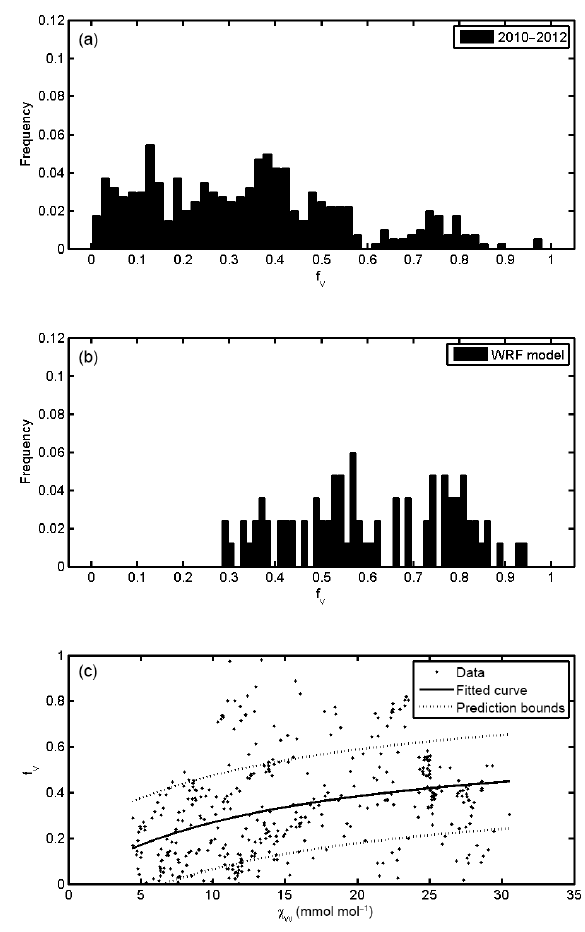
Figure 9. Normalized frequency distributions of PBL water vapor partitioning ( f v ) for June to August 2010–2012 (a) and normal- ized frequency distribution for estimates derived from the Weather Research and Forecasting (WRF3.5) model simulations for June– August 2010 (b) . Here, the average daytime values represent the fraction of water vapor in the PBL derived from local evapora- tion evaluated under the following conditions, evaporation>0, and − u d X/ d x >0 and − v d X/ d y >0. Panel (c) shows the fraction of evaporated vapor contained in the planetary boundary layer as a function of total water vapor mixing ratio. The prediction bounds represent 1 σ